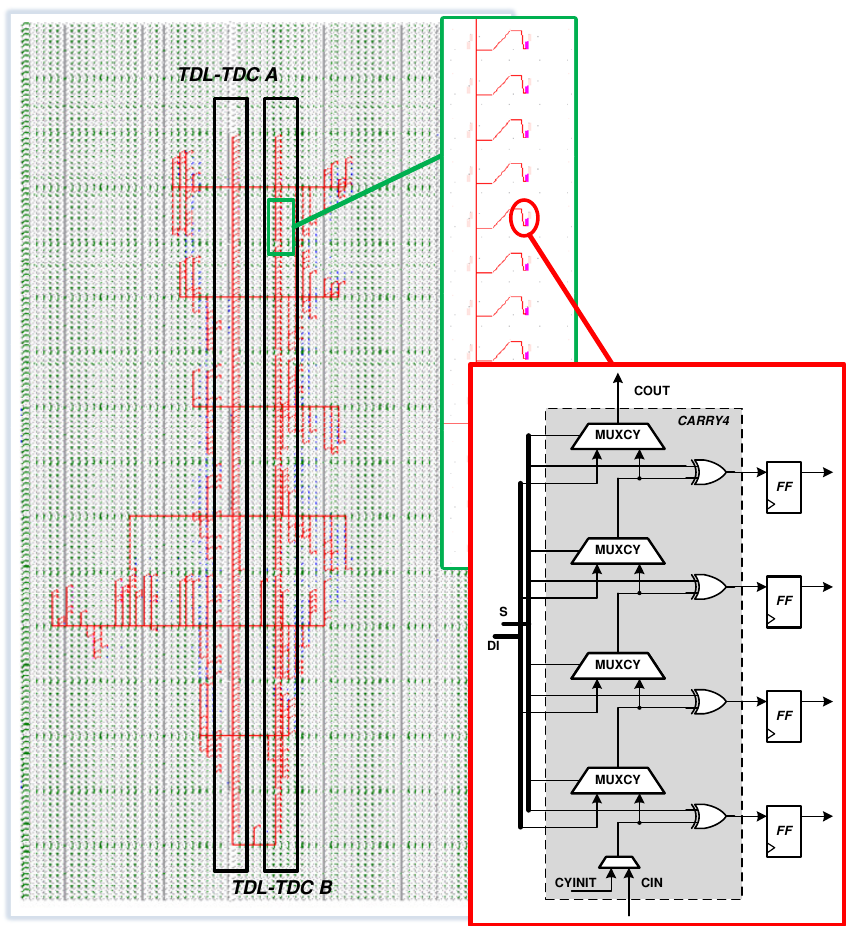
Figure 2. Layout view of two delay chains in the proposed FPGA-based DDL-TDC.